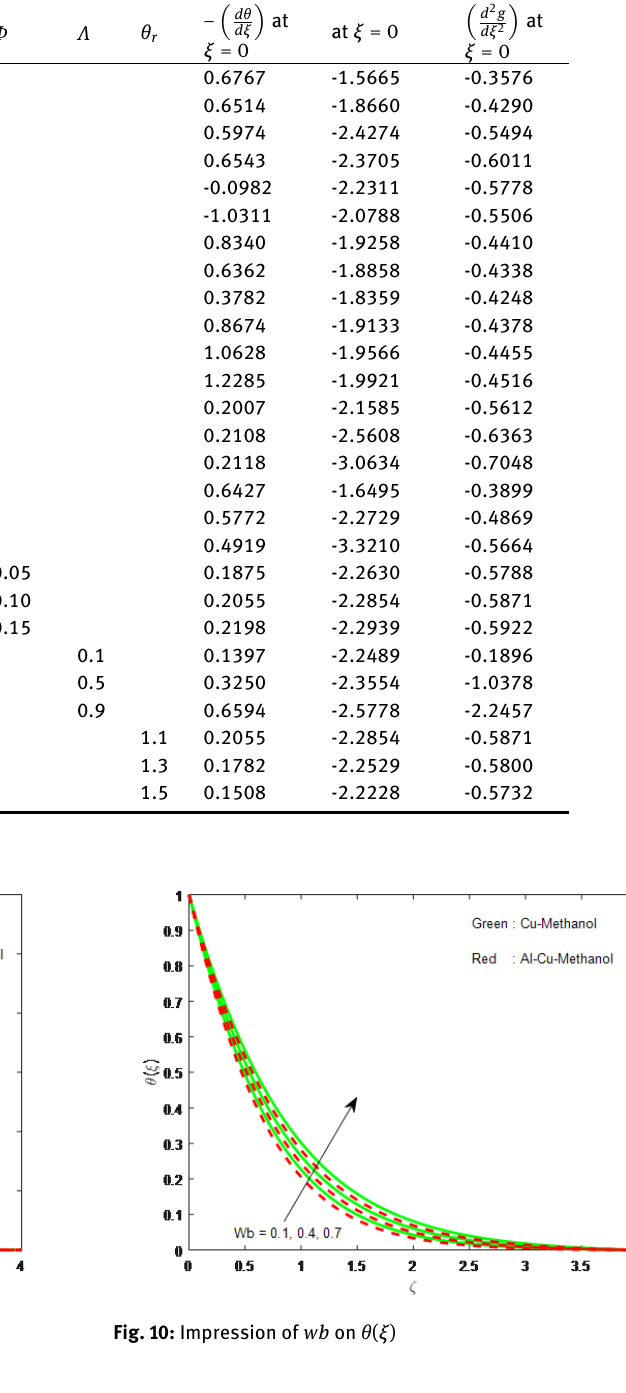
come that temperature decays with H , H < 0. The be- ity field. Since thicker liquid supplies heat energy, we dis- 1 2 haviorofdimensionlessvelocityandtemperaturewithdis- cover an upsurge in θ ( ξ ) fro Fig. 10. tinct values of Weissenberg number ( Wb ) is bestowed in The nature of the curves f (cid:48) ( ξ ), g (cid:48) ( ξ ) and θ ( ξ ) under Figs. 8-10. An improvement in the values of gives thickness the action of stretching ratio parameter Λ is portrayed to the fluid and hence deterioration in fluid motion occurs. in Figs. 11-13. Velocity in y − direction grows with Λ but As a consequence, greater values of Wb shrinks the veloc- shrinks in x −direction. Also, it is fascinating to